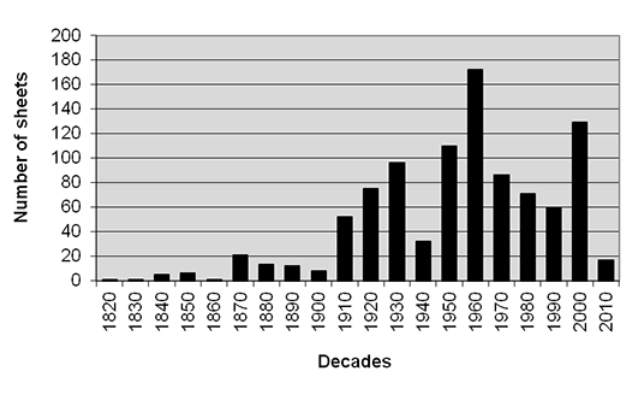
Fig. 1 Number of Pinaceae family sheets collected in individual decades